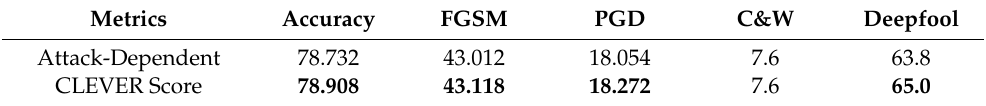
Table 4. Comparison of search algorithms with different robustness evaluation